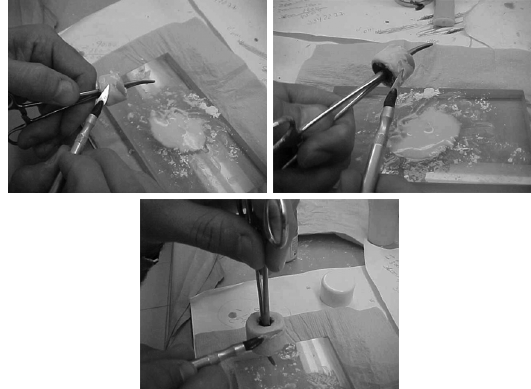
Figure 3. Preparation of the metal-porcelain cylinder set.